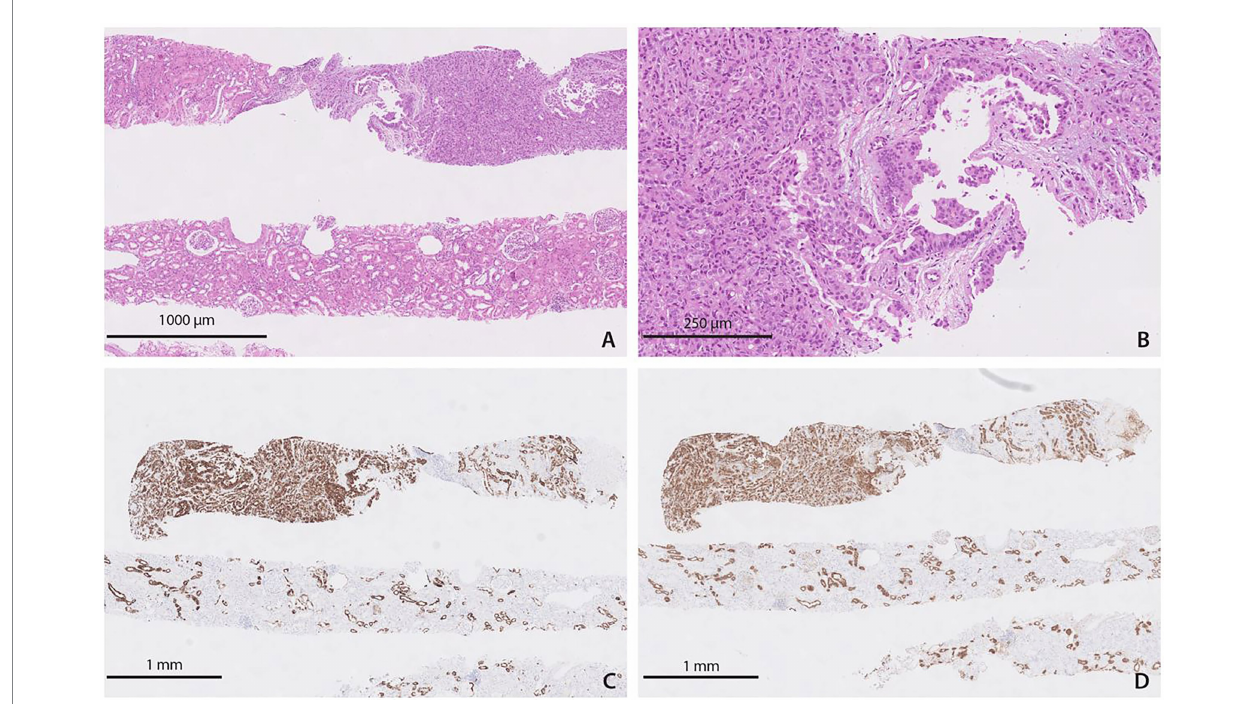
FIGURE 2 Histopathological findings in the recipient of the right kidney. (A) Adenocarcinoma in the surveillance biopsy of the graft [hematoxylin–eosin (H&E)]. (B) Adenocarcinoma in the surveillance biopsy of the graft – closer view (H&E). (C) Adenocarcinoma in the surveillance biopsy of the graft expressing cytokeratin 7 (immunohistochemical staining). (D) Adenocarcinoma in the surveillance biopsy of the graft expressing mucin-1 protein (immunohistochemical